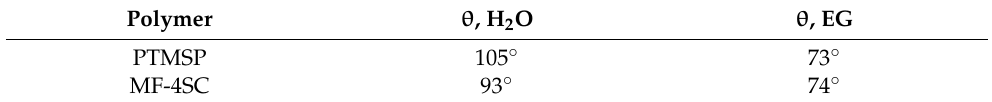
Table 2. The contact angles on the PTMSP and MF-4SC surfaces of the membrane.